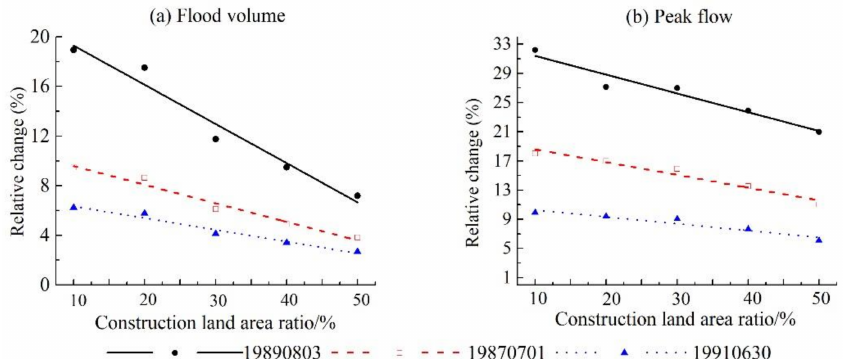
Figure 6. The potential changes of relative change in Q v and Q p between with and without polder conditions for different flood magnitudes under different urbanization scenarios ( a ) flood volume, ( b ) peak